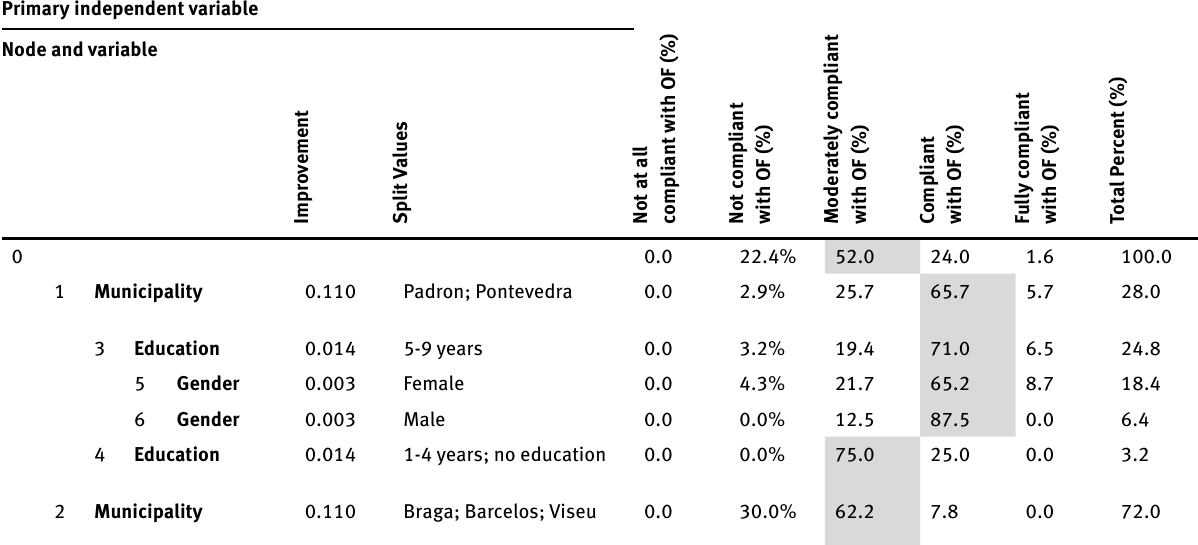
Table 7: Tree table for variable compliance with the practices of OF (CPOF) Primary independent